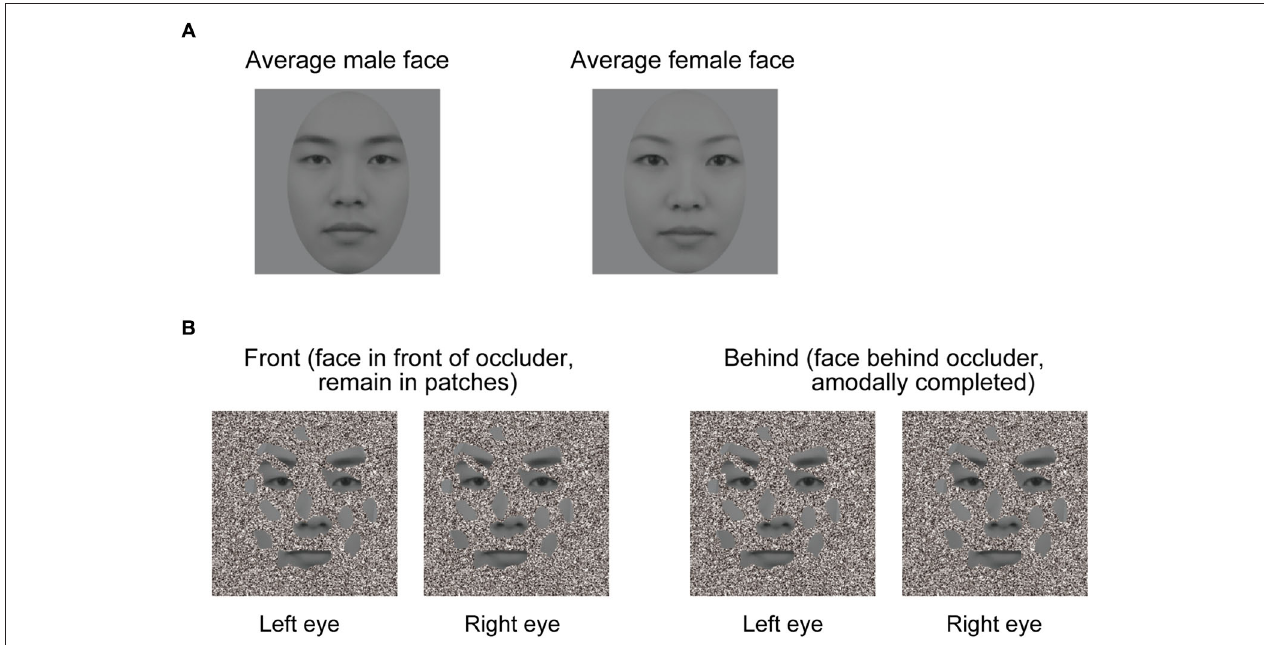
as a complete face when the occluder is in the near depth plane (left panel), but not in the far depth plane (right panel), even though the stimuli presented in the front and behind conditions were identical. In the right panel, face patches appear like a collection of disjointed face patches hovering in depth. A good example of this is Figure 1B in Hegdé et al. (2008).